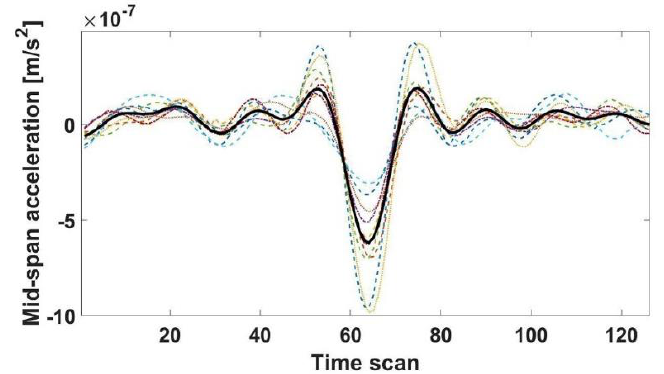
Figure 14. Bridge mid-span acceleration responses to unit-weight axle from 10 truck responses and the mean influence line response at 20 °C temperature.